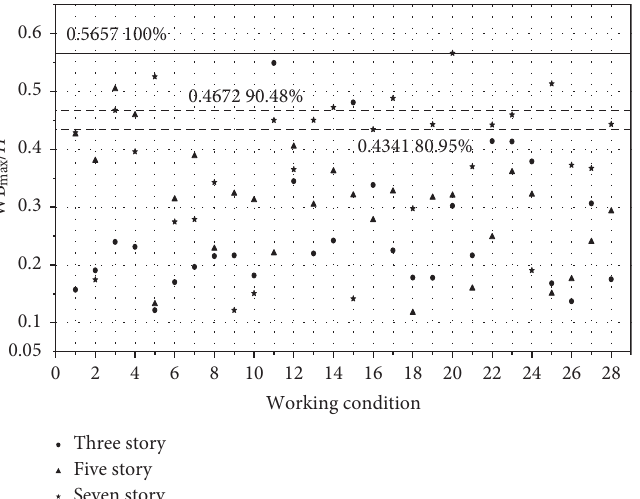
Figure 26: Statistic of the maximum influence width coefficient of the masonry structure along the Z axis under the continuous collapse mode of various working conditions.